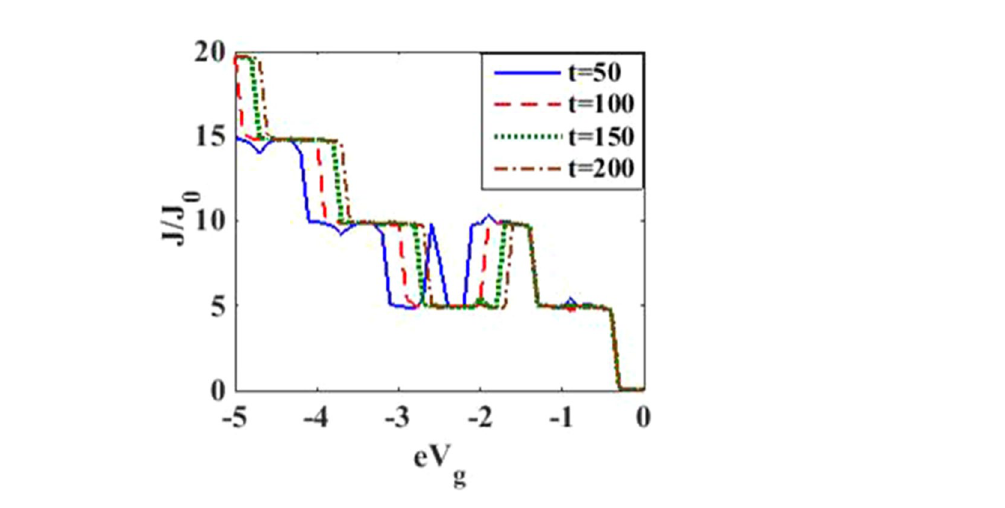
Figure 13. J / J 0 versus eV g for various values of time at (cid:31) = 0.6 and eV b = 0.5 .